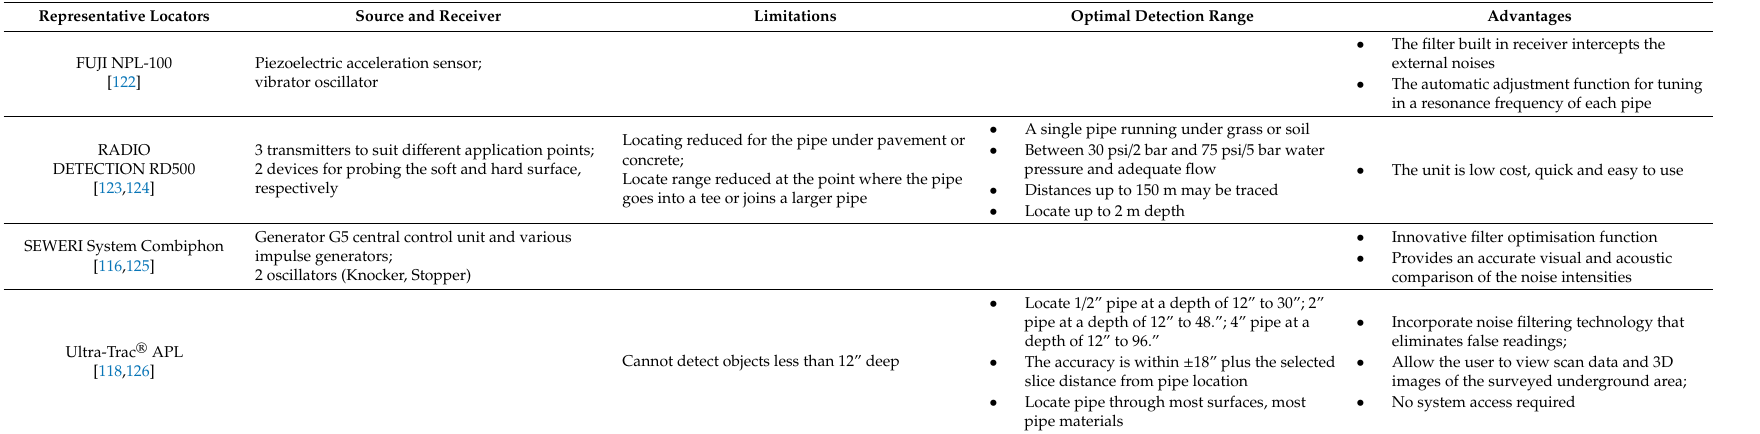
Table 2. Main features of di ff erent acoustic pipe locators according to their